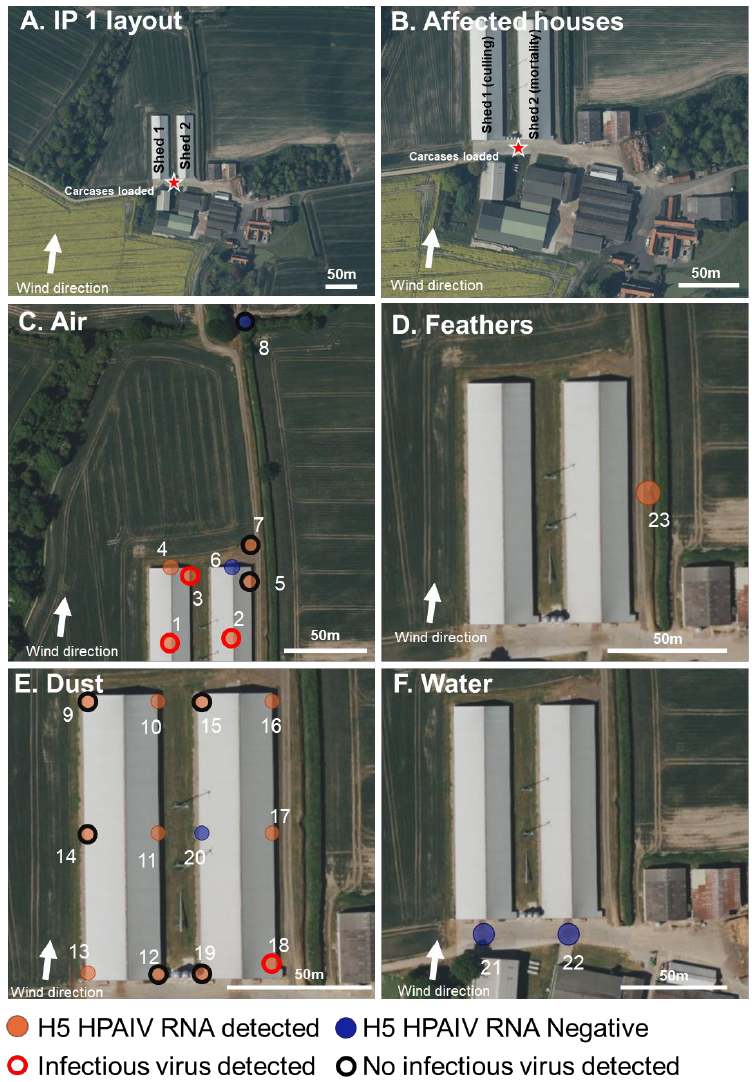
Figure 1. Infected premises 1 (IP1): Environmental sampling and presence or absence of H5 HPAIV RNA at a duck IP. ( A , B ). Map showing the layout of the IP with the two affected houses indicated, wind direction at time of sampling, the site where carcasses were loaded onto trucks (red star), and mortality and culling indicated. ( C – F ). The location of the environmental sampling and H5 RRT-PCR results showing the presence (orange) or absence (blue) of H5 HPAIV RNA in the sample and the positive isolation of infectious virus (red outline) or negative isolation of infectious virus (black outline). Samples were collected from air filters ( C ), feathers ( D ), dust ( E ), and water ( F ). Locations of wet straw samples (n = 2) and an Op swab from a dead duck (n = 1) are not shown but are indicated in Table